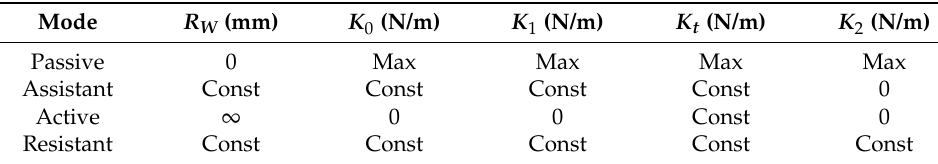
Table 1. The controller parameters of different rehabilitation training